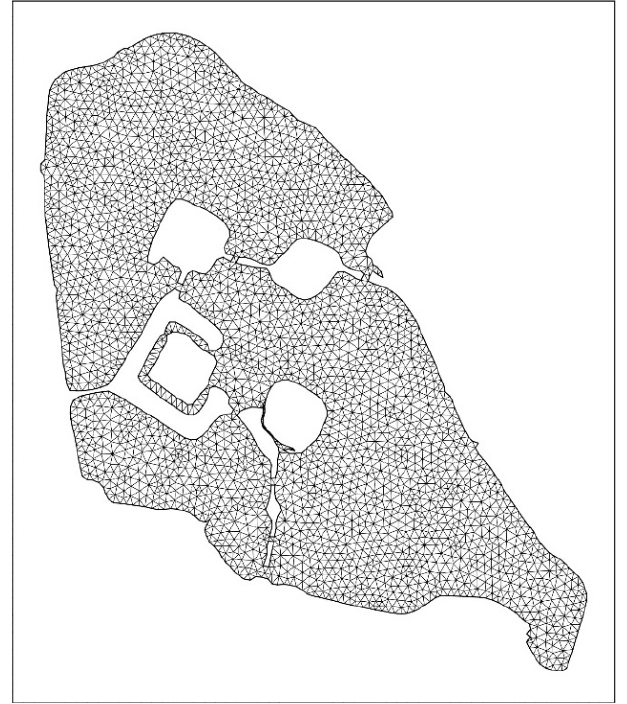
Figure 2. Xuanwu Lake model grid.